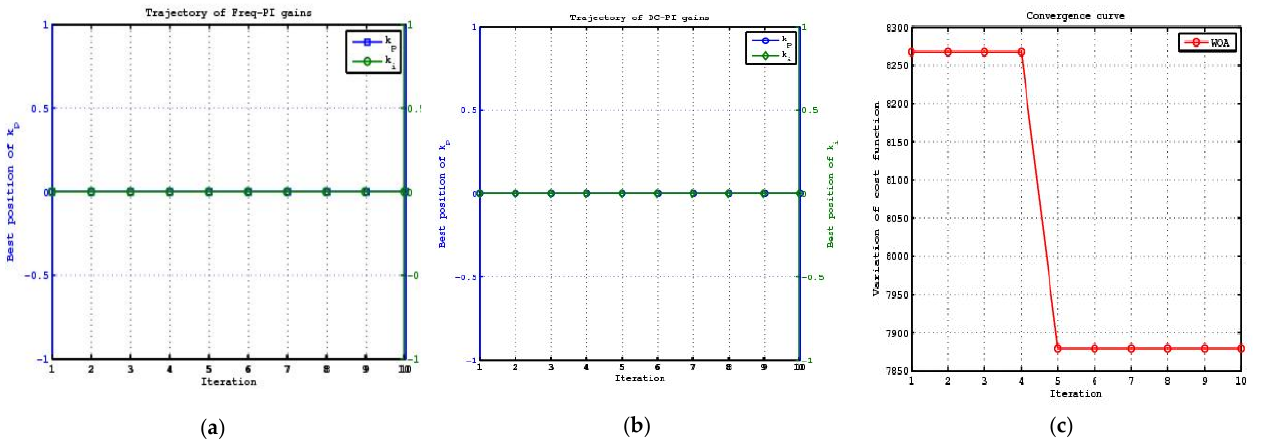
Figure 5. ( a ) Trajectory of frequency PI gain; ( b ) Trajectory of AC PI gain; ( c ) Convergence curve using Particle Swam Optimization (PSO).